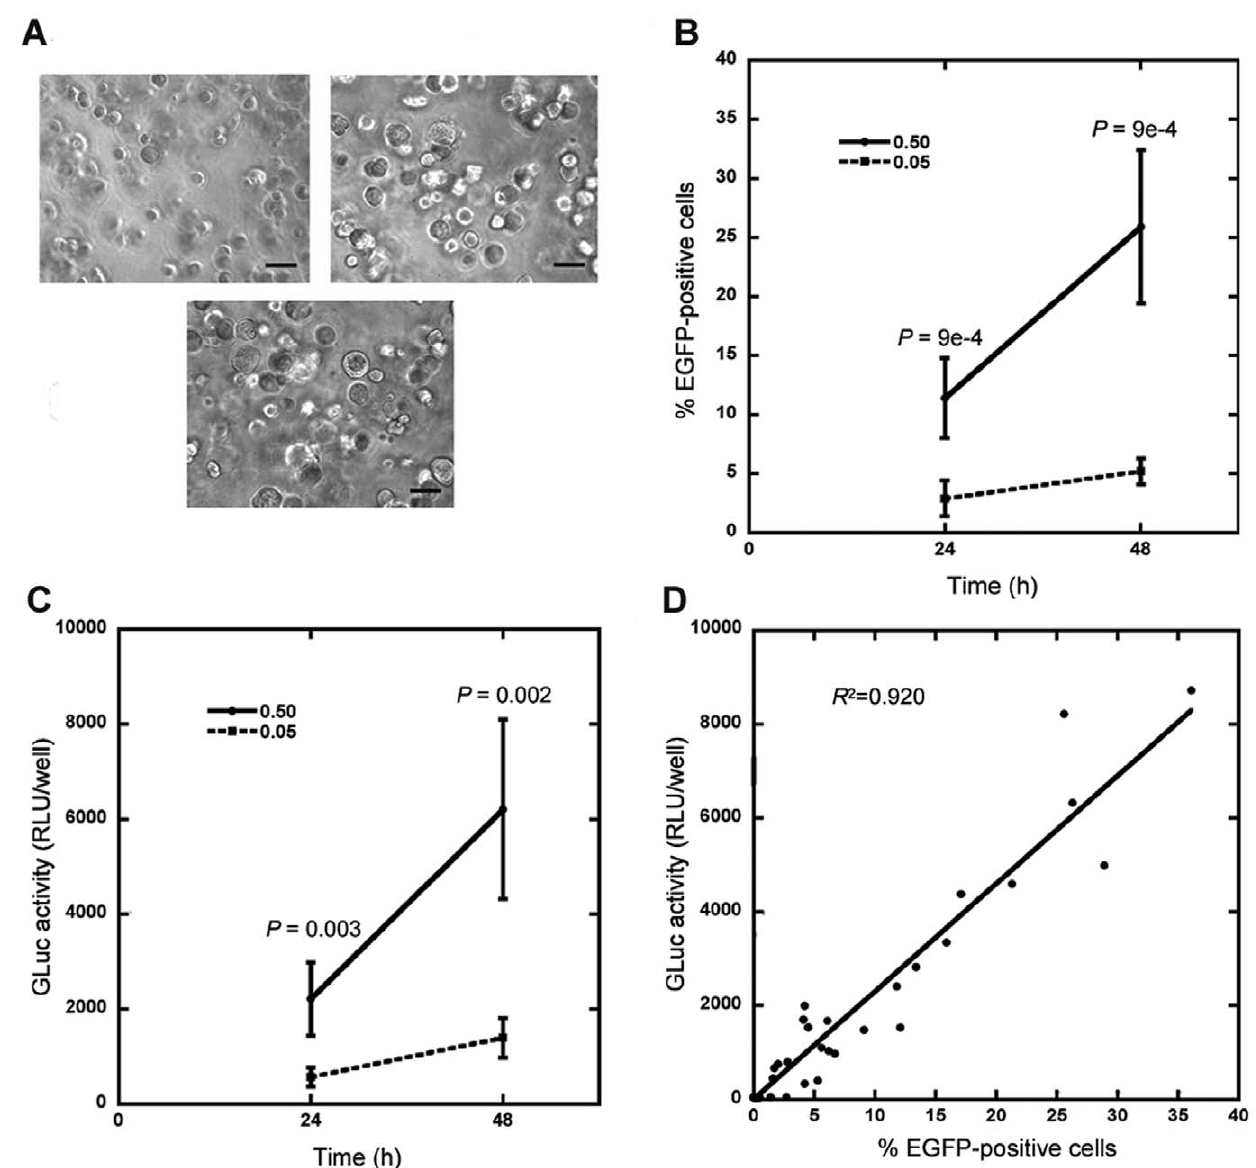
Figure 1. Reporter constructs to normalize for transfection efficiency during structure formation in hydrogels. (A) MCF-7/WS8 cells growing within Matrigel hydrogels without DNA complexes began as individual cells at day 1 (top left panel) and formed multi-cellular spheroids by day 3 (top right panel), a process that was not inhibited by 0.5 m g DNA lipoplexes (bottom panel). Scale bar, 200 m m. (B–D) Cells were transfected with reporter genes for EGFP and GLuc in parallel (0.5 or 0.05 m g DNA total with an pEGFP:pGLuc mass ratio of 9:1) within hydrogels. Percentage of EGFP positive cells (B) and activity of GLuc (C) increased with DNA amount at both 24 and 48 h. Values are means 6 s.d. from two independent experiments carried out in triplicate. GLuc activity correlated with %EGFP-positive cells (D).